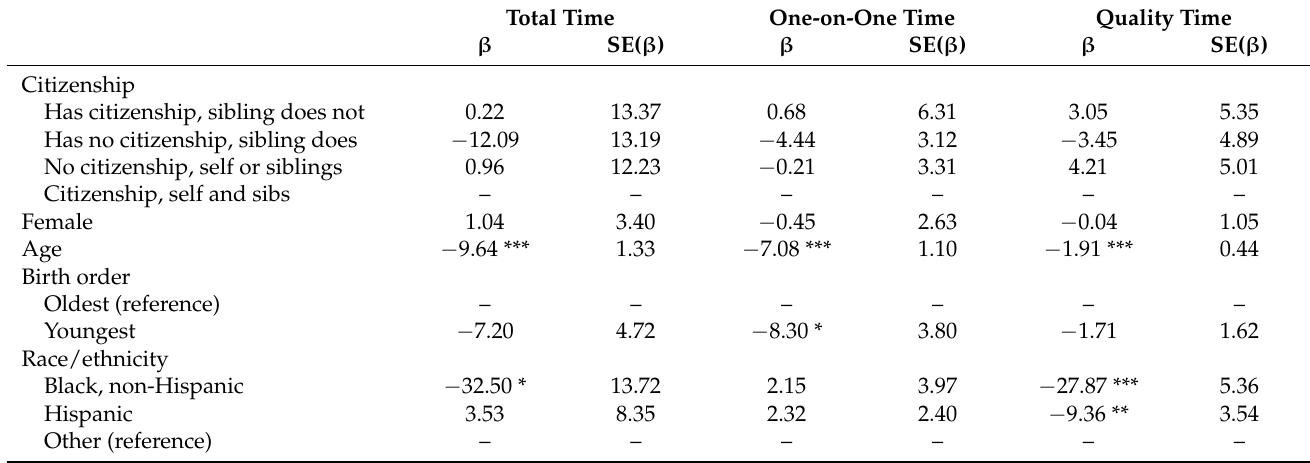
Table A2. Associations between Childhood Citizenship Status and Parental Time Investments when Controlling for Parent English Language Proficiency (N =